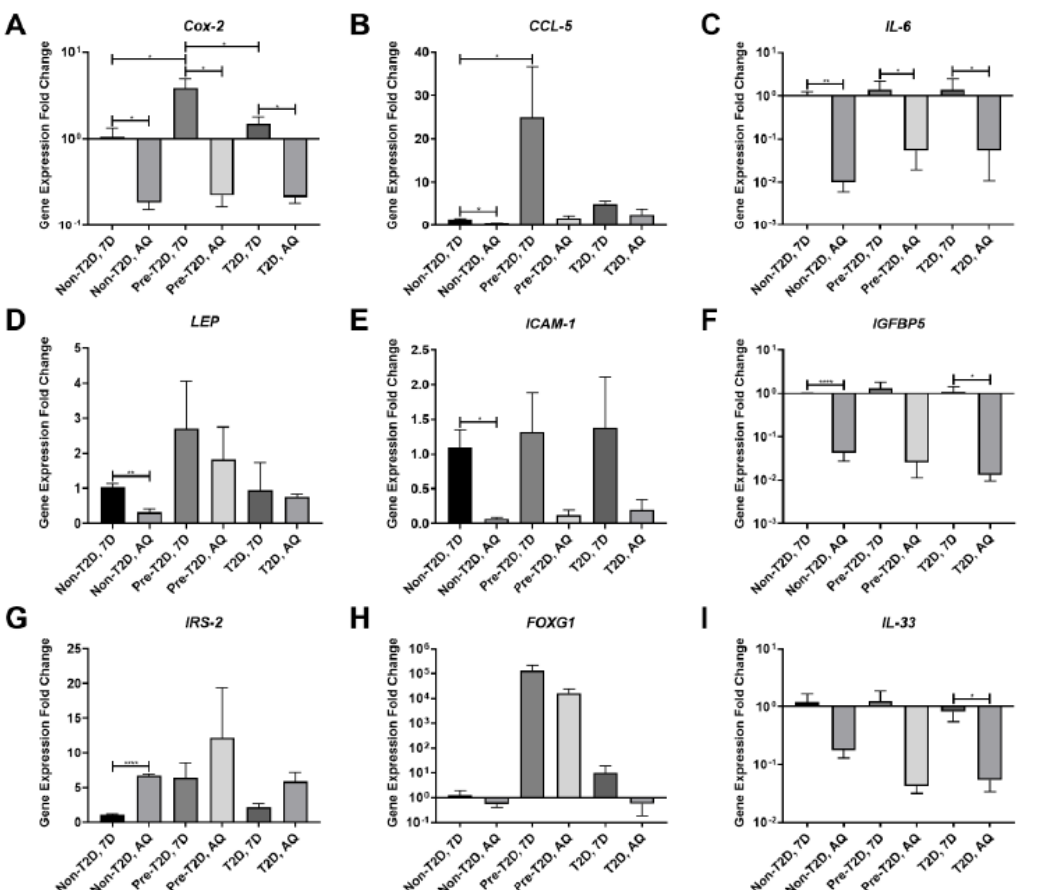
Figure 3. ( A–I ) Decreased expression of pro-inflammatory cytokines by IPFP-ASCs after Figure 3. ( A – I ) Decreased expression of pro-inflammatory cytokines by IPFP-ASCs after adipocyte differentiation. ( n = 3, * p < 0.05, ** p < 0.01, **** p < 0.0001). Non-T2D: Non-Type II diabetes mellitus, Pre-T2D: Pre-Type II diabetes mellitus, T2D: Type II diabetes mellitus.